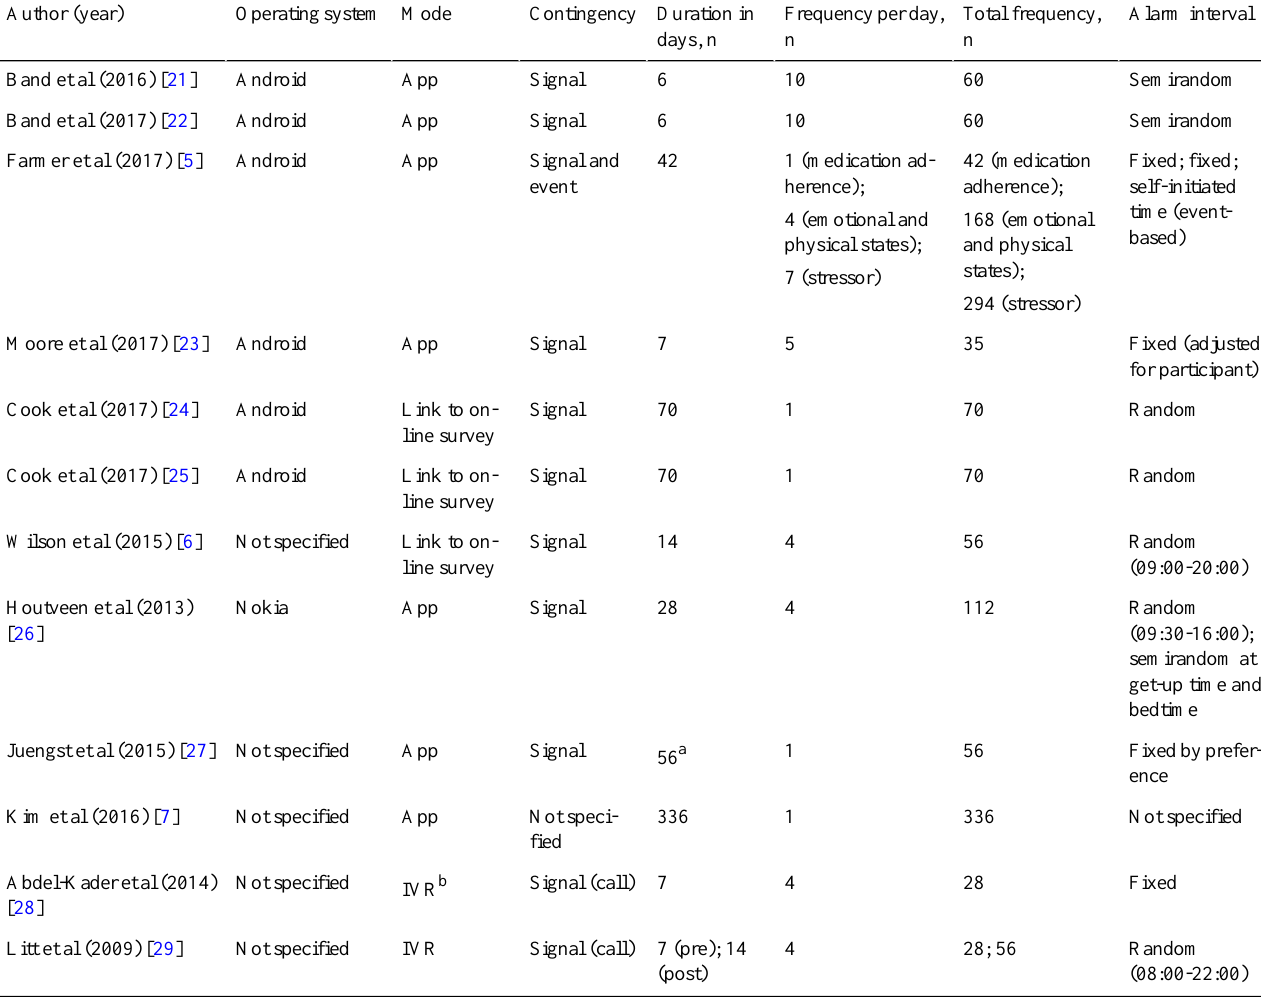
Table 2. Completion rate and momentary data analysis